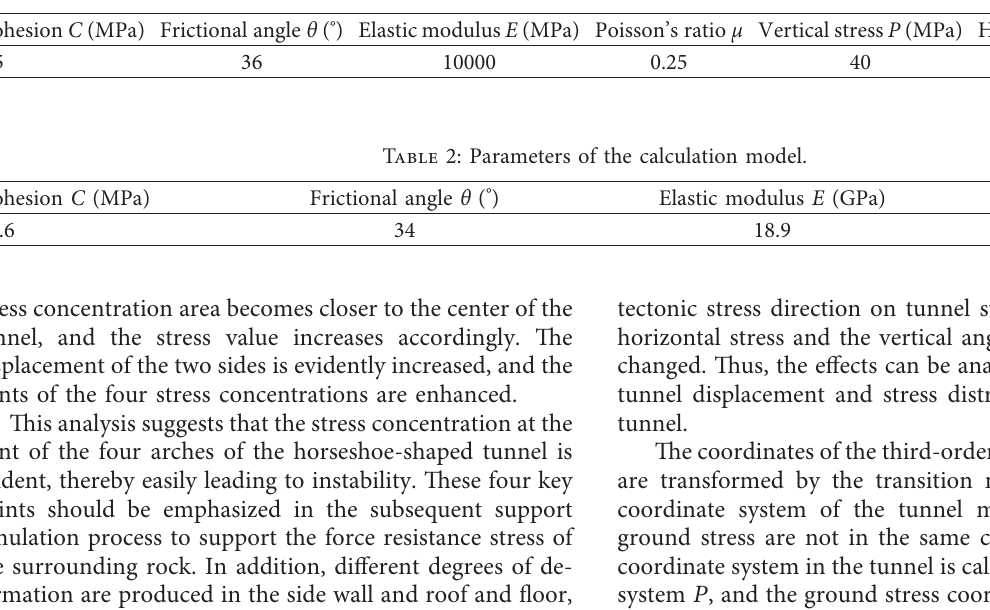
Table 1: Parameters of calculation model.